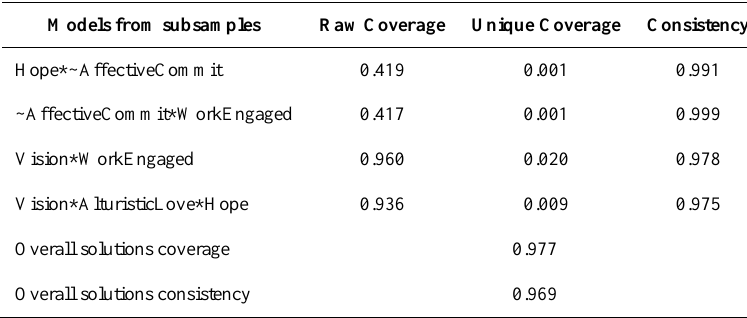
Table 7. Solutions (models) from subsamples